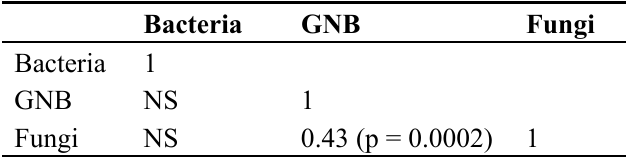
GNB: Gram-negative bacteria; NS = not statistically significant at p =